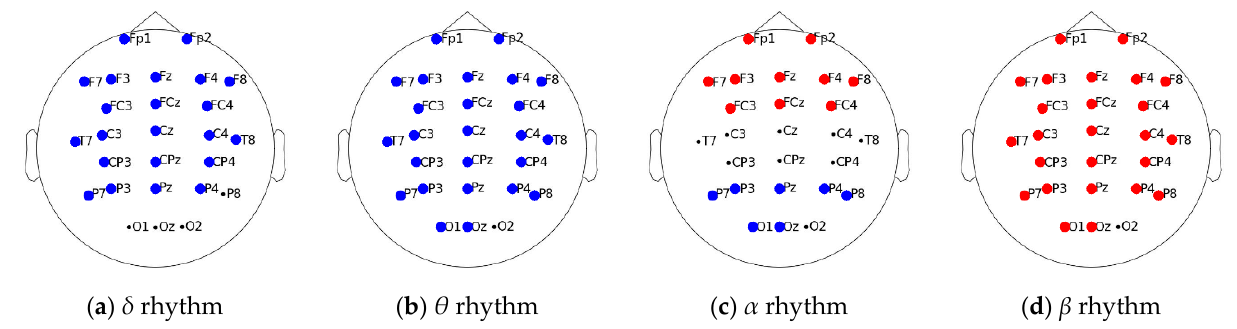
Figure 8. PSCs and NSCs for four rhythms of Sub 8.